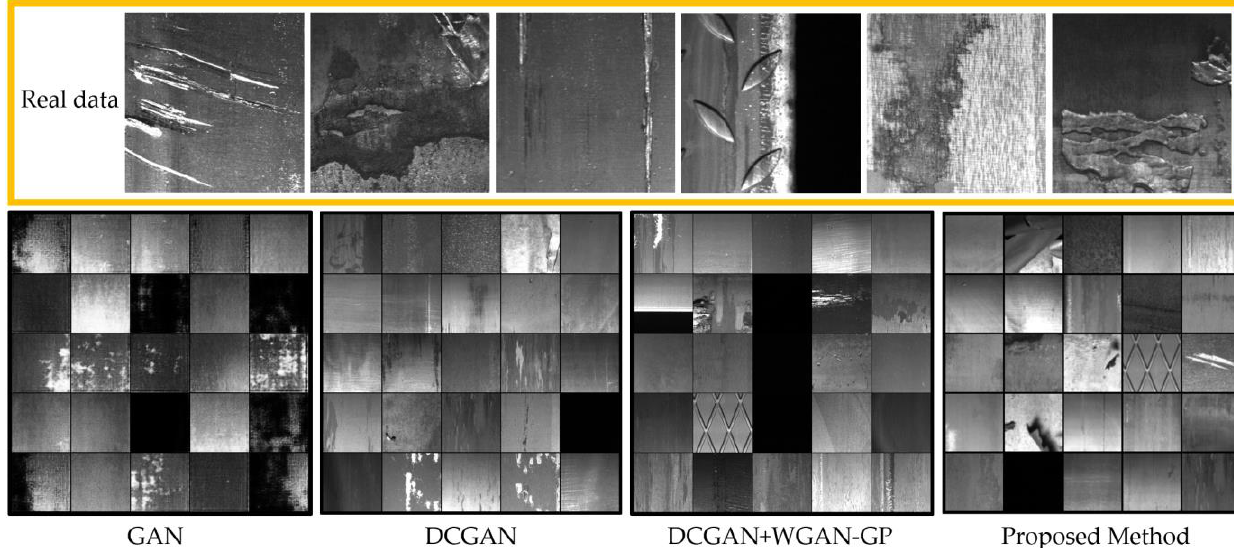
Figure 7. Visual comparison of the results of each method.